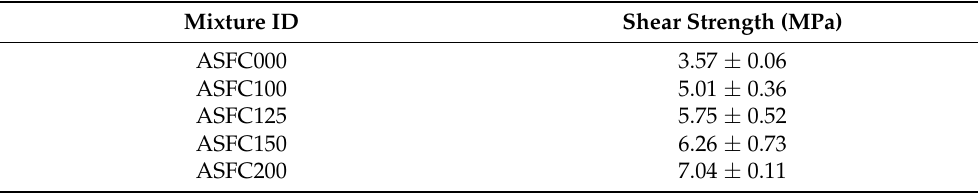
Table 8. Results of shear strength